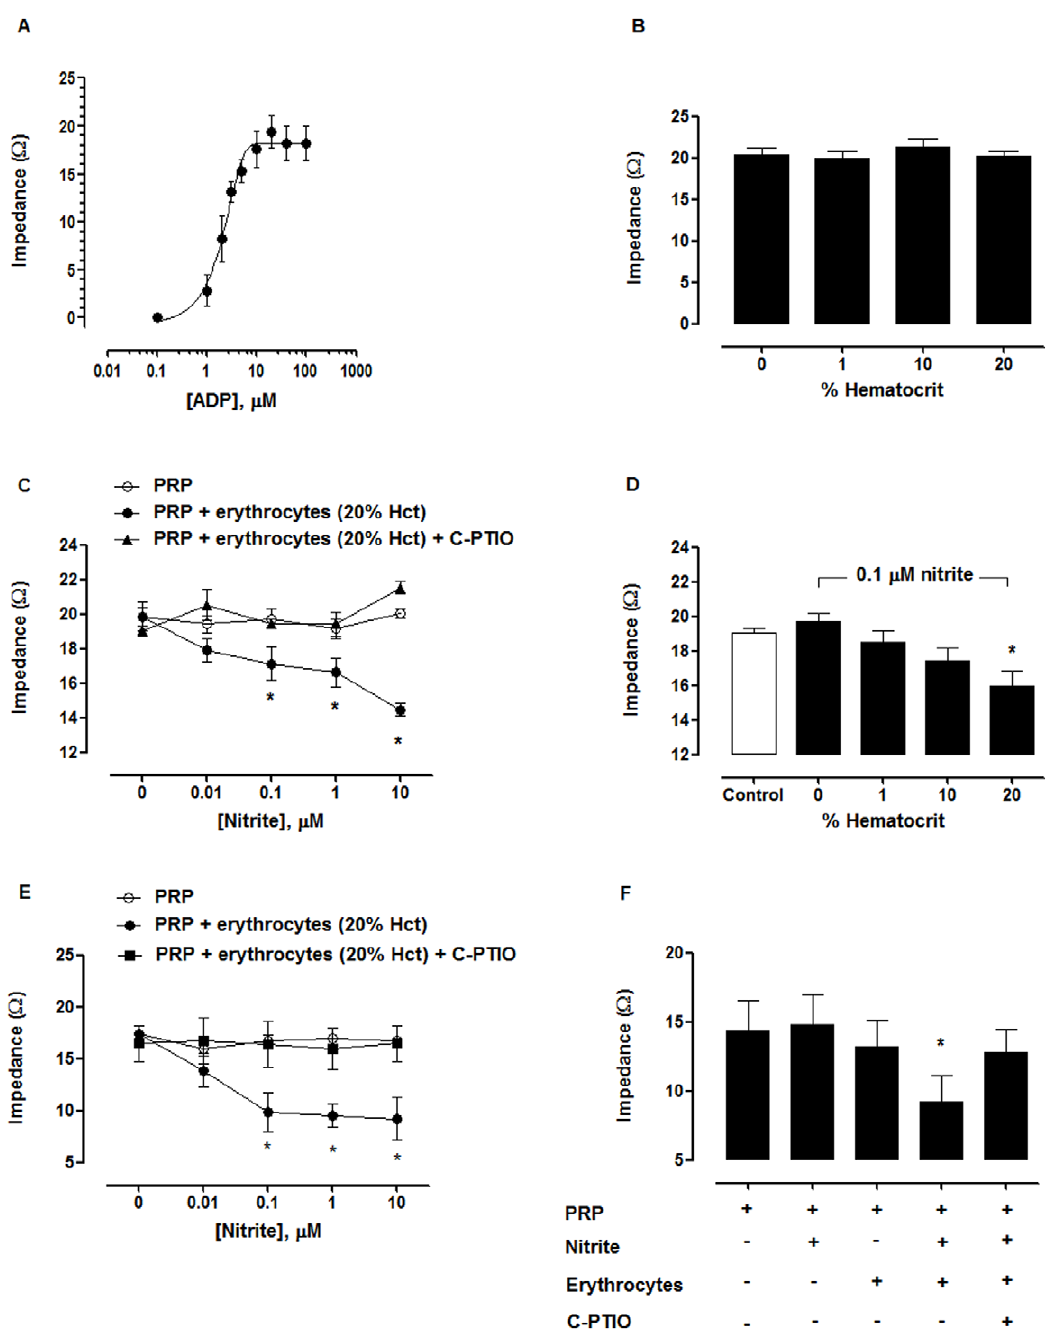
Figure 2. Nitrite + erythrocytes inhibited platelet aggregation. (A) ADP induced platelet aggregation in PRP + erythrocytes (20% hematocrit) in the concentration dependent manner. (B) Erythrocytes at 0, 1, 10 and 20% hematocrit did not have effect on ADP-induced platelet aggregation in the absence of nitrite. (C) Nitrite + erythrocytes (20% hematocrit) inhibited ADP-induced platelet aggregation. Nitrite was incubated in PRP or PRP + erythrocytes in the presence or absence of 200 m M C-PTIO for 5 min before induction of aggregation by ADP. * P , 0.05 compared with PRP and PRP + erythrocytes + C-PTIO (ANOVA). (D) The inhibitory effect of 0.1 m M nitrite was dependent on hematocrits. PRP and PRP + erythrocytes (1, 10, and 20% hematocrit) were incubated with 0.1 m M nitrite for 5 min before induction of platelet aggregation by 20 m M ADP. ADP-induced platelet aggregation in the absence of nitrite was shown in the control group. * P , 0.05 compared with PRP + nitrite at 0% hematocrit (ANOVA). (E) Nitrite + erythrocytes inhibited collagen-induced platelet aggregation. PRP or PRP + erythrocytes samples (20% hematocrit) were incubated with nitrite in the presence and absence of 200 m M C-PTIO for 5 min and then the aggregation was induced by 2.5 m g/mL collagen. * P , 0.05 compared with PRP and PRP + erythrocytes + C-PTIO (ANOVA). (F) Nitrite + erythrocytes inhibited U46619-induced platelet aggregation. 0.1 m M nitrite was incubated in PRP or PRP + erythrocytes (20% hematocrit) in the presence or absence of 200 m M C-PTIO for 5 min. Then, the aggregation was induced by 1 m M U46619. * P , 0.05 compared with PRP + erythrocytes and PRP + erythrocytes + C-PTIO (ANOVA). All experiments were performed at 37 u C. Data are means 6 SEM (n $ 3).